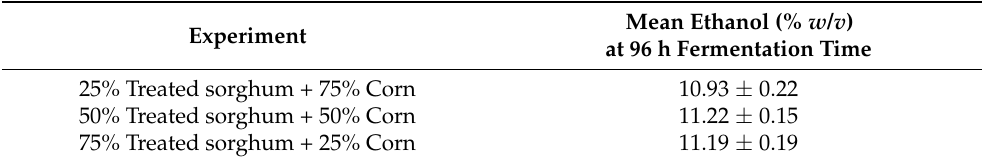
Table 7. Corn and sorghum fermentations with